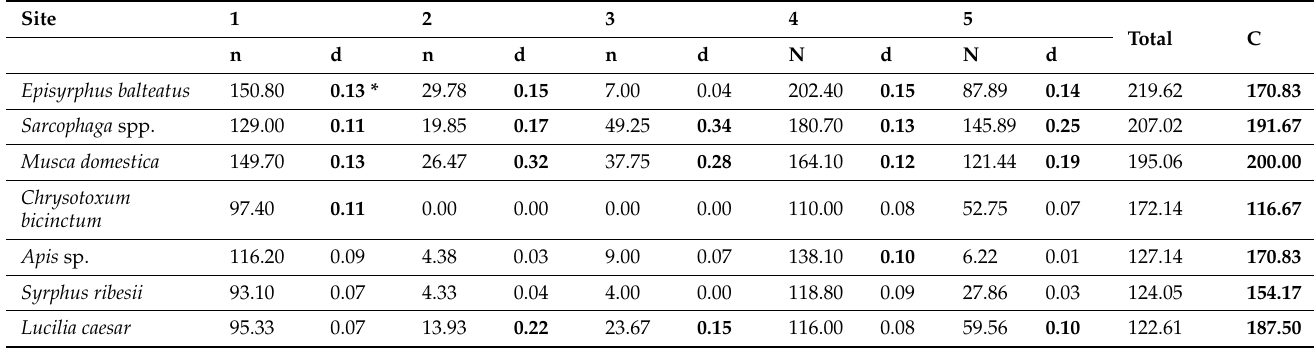
Table 2. The species and community responses of pollinators observed on Fallopia baldschuanica flowers in